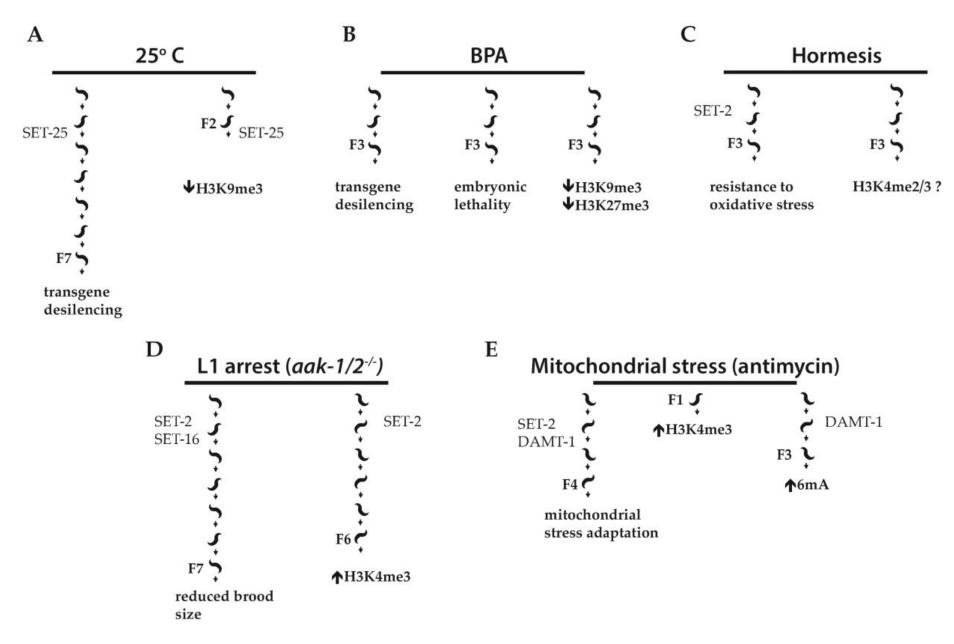
Figure 2. Examples of stress-induced transgenerational inheritance in C. elegans